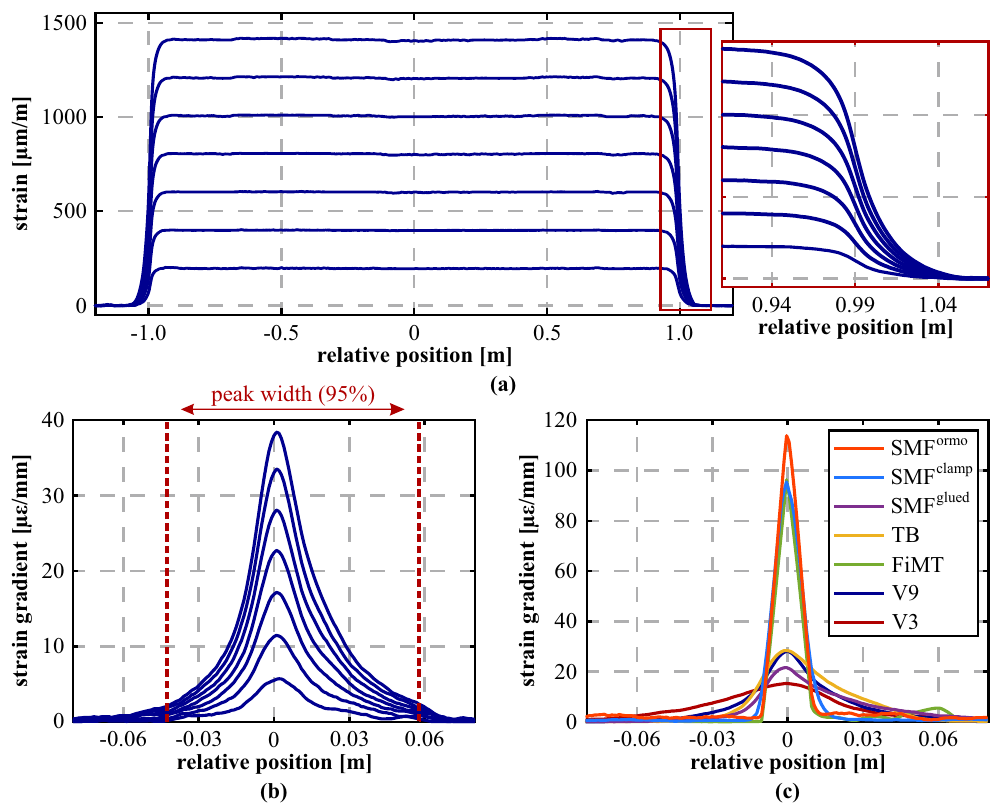
Figure 5. Analysis of spatial resolution impact: ( a ) Distributed strain profiles along strained section of sensing cable BRUsens V9. ( b ) Strain gradient at different load levels. ( c ) Strain gradient for different fiber types at 1000 µ ε